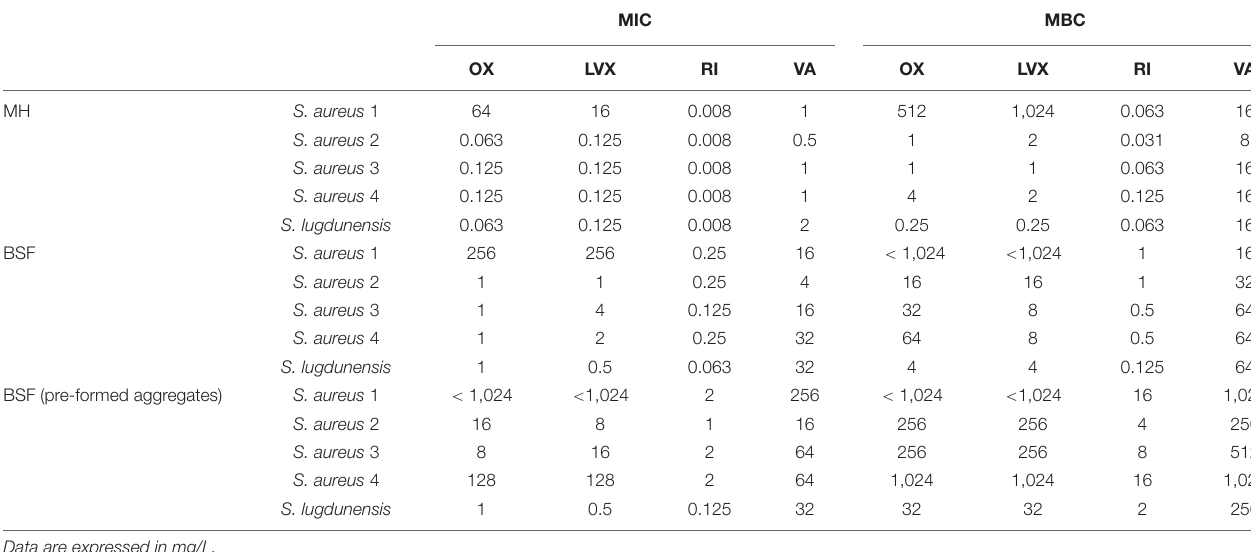
TABLE 1 | Minimum inhibitory concentration (MIC) and minimum bactericidal concentration (MBC) of oxacillin (OX), levofloxacin (LVX), rifampin (RI) and vancomycin (VA) against staphylococci in Muller Hinton (MH) broth and in bovine synovial fluid (BSF). MIC MBC